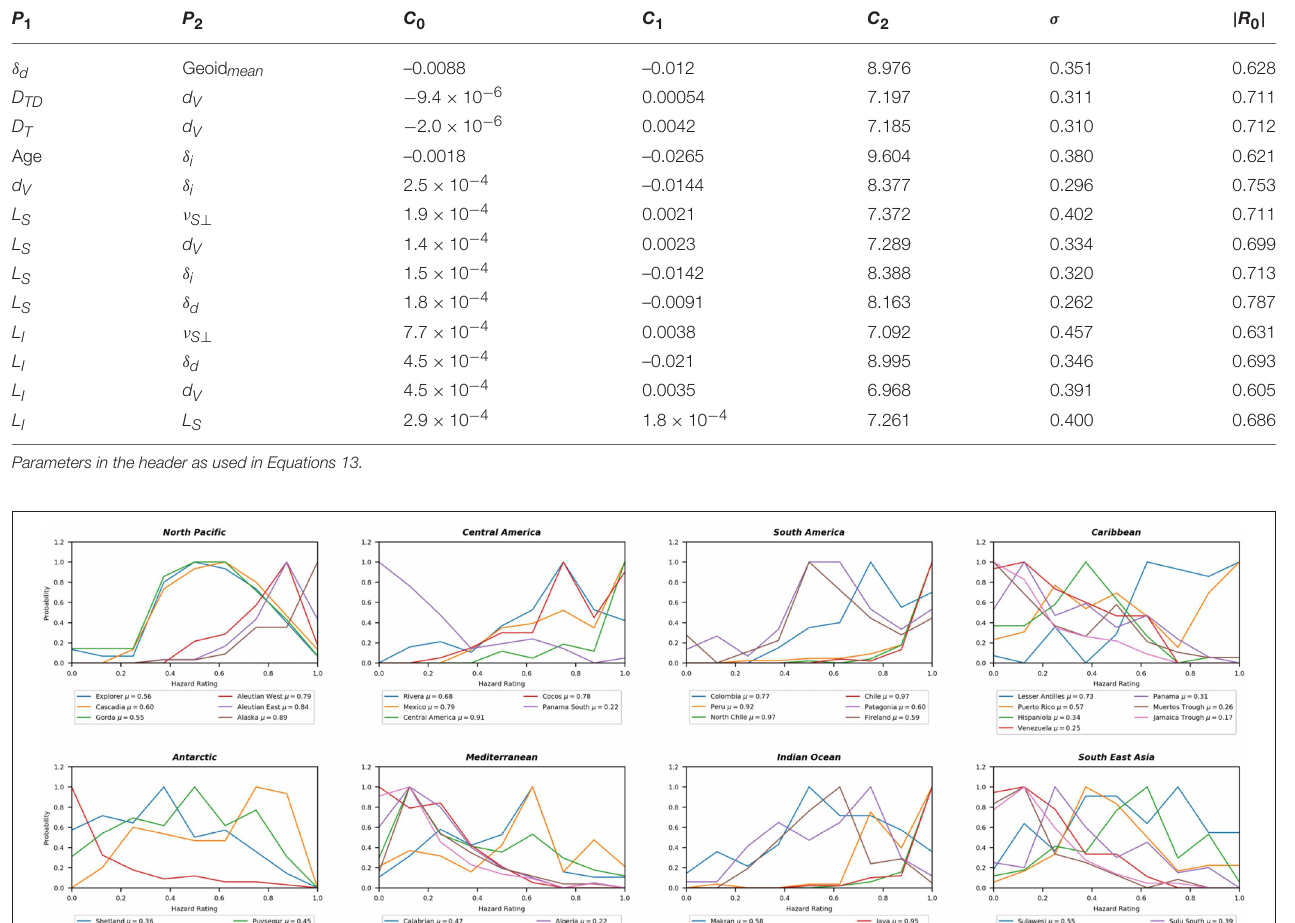
Frontiers in Earth Science |